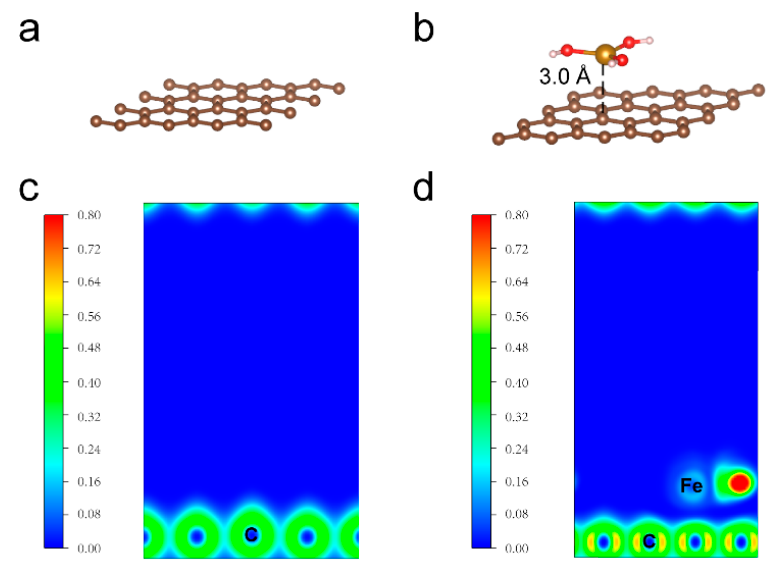
Figure 1. Schematic of G ( a ) and Fe@G ( b ), ELF diagram of G ( c ) and Fe@G ( d ).